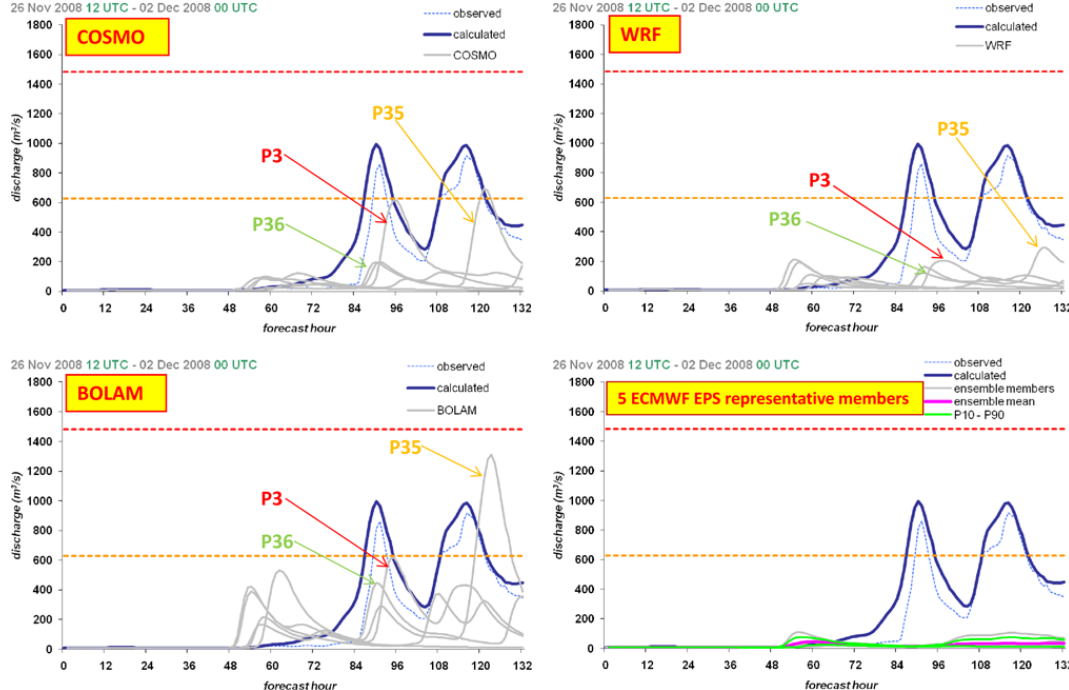
Fig. 7. Discharge forecasts (m 3 s − 1 ) as a function of the forecast range ( h ) obtained by feeding the TOPKAPI with the rainfall predicted by the five members of each model of the multi-model ensemble system and for the five representative members of the ECMWF global EPS. Forecasts are initialized at 12:00UTC, 26 November 2008 (long range; see text). The rain-gauge-driven (thick blue line) and the observed (blue dashed line) discharges are also plotted for reference. The forecasts driven by a particular representative member of the global ensemble are indicated with arrows and with the member number. Orange (red) horizontal line indicates warning (alarm)